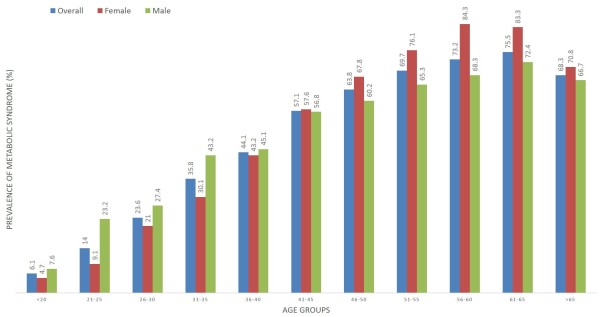
Prevalence of MetS based on quartiles of age and gender, according to ATPIII criteria. The overall prevalence of MetS increased uniformly with increase in age in both males and females. In males, a direct relationship between age and the full MetS was found in the range of 20–40 years which was lost in later age groups. However, in females, there was an increase in the prevalence of MetS from age 41 to 70 years. A decrease in the prevalence of MetS was observed in the age group of >65 years.